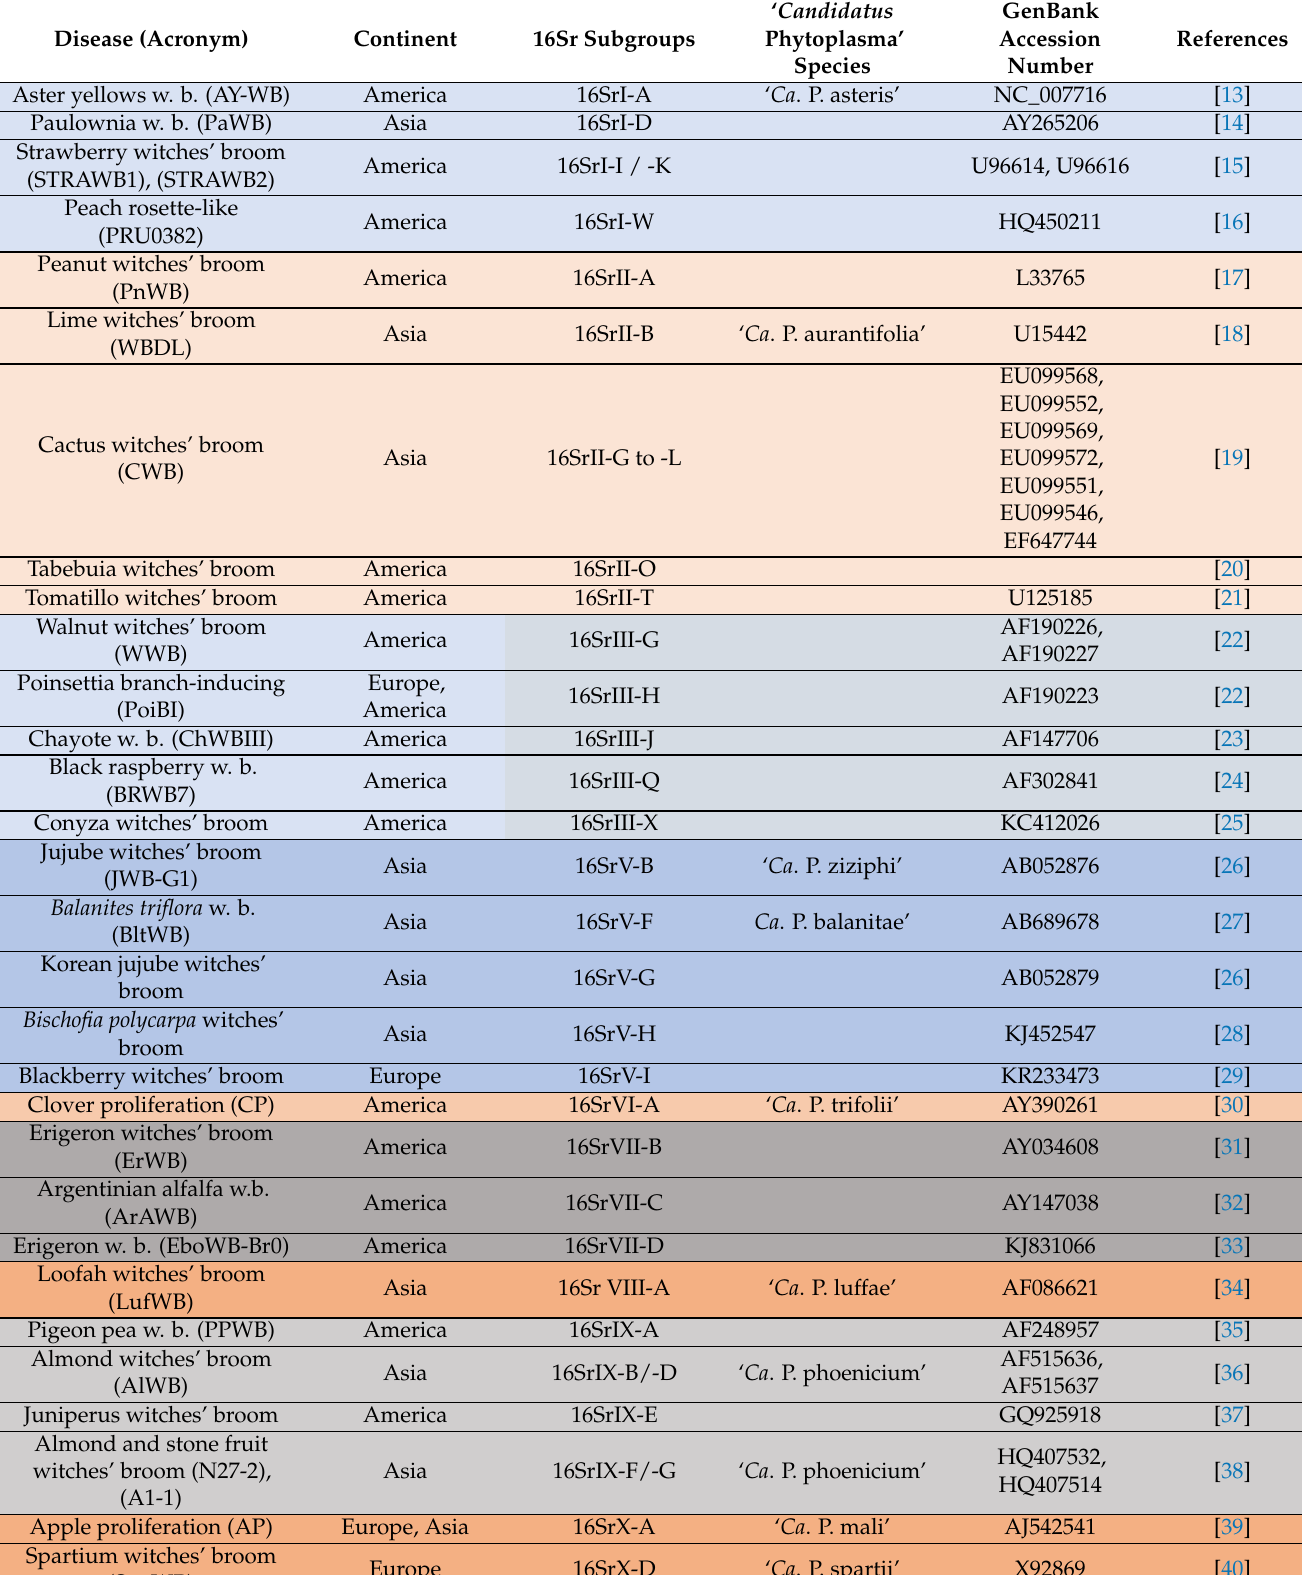
Table 1. Molecular diversity and geographic distribution of selected phytoplasmas belonging to different ribosomal groups/‘ Candidatus Phytoplasma’ species (marked by different color) associated with witches’ broom